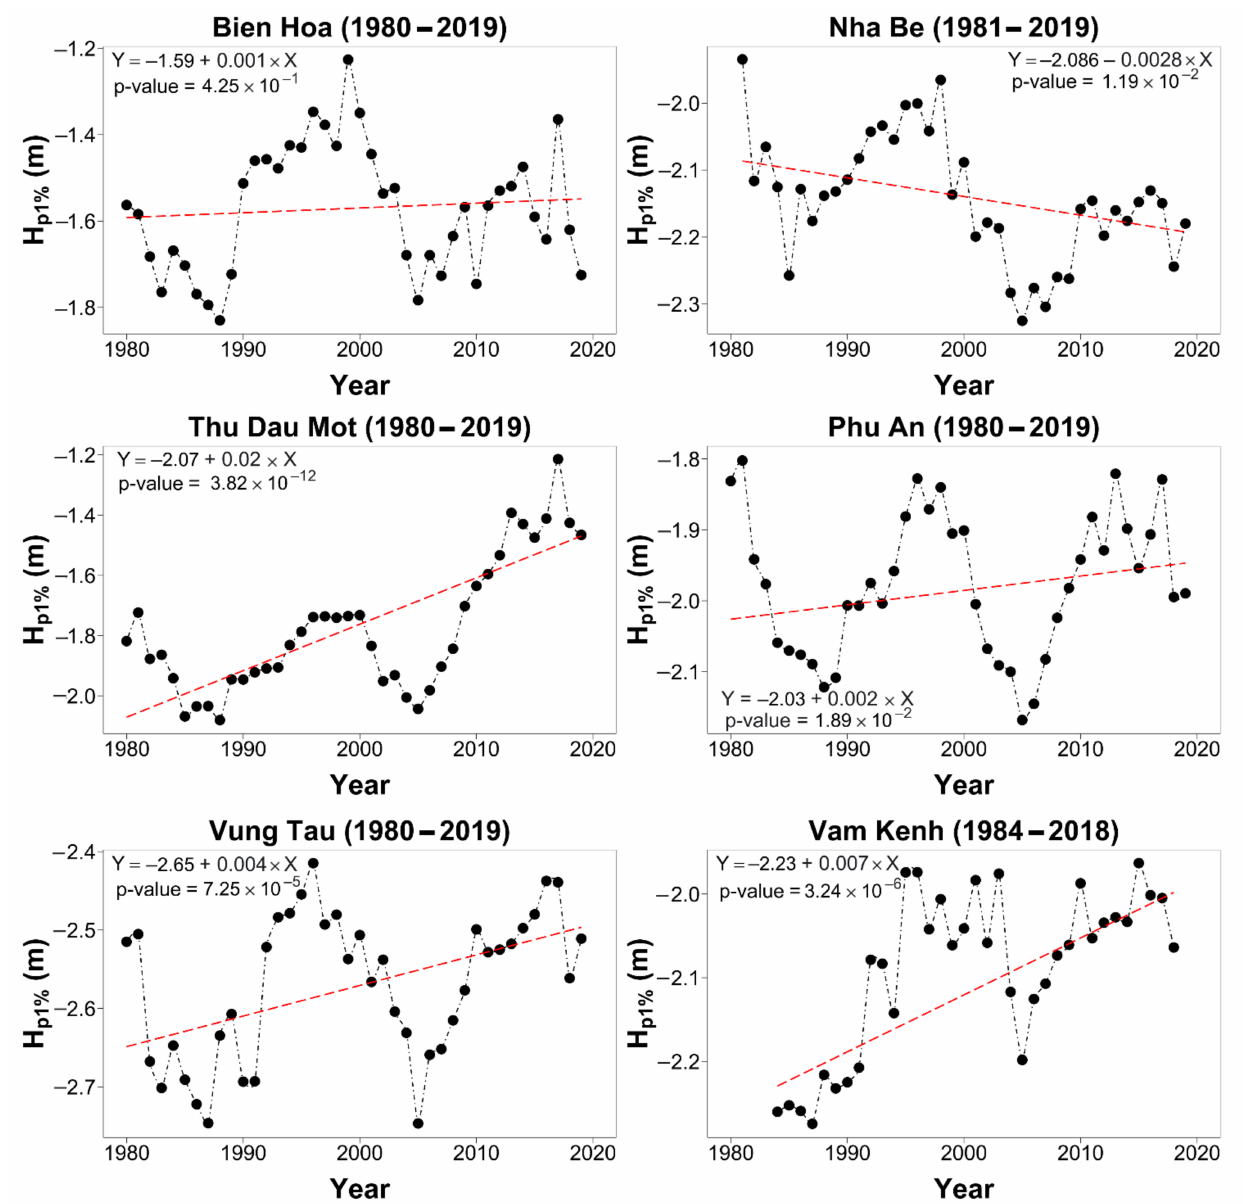
Figure A2. Water level trends H p1%